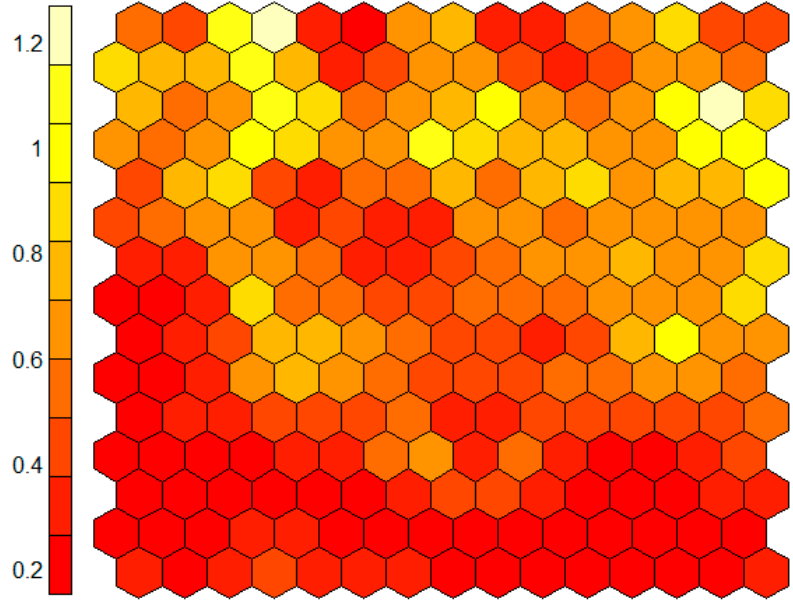
Figure 3. U-matrix showing the relative distance between neurons in the trained map.